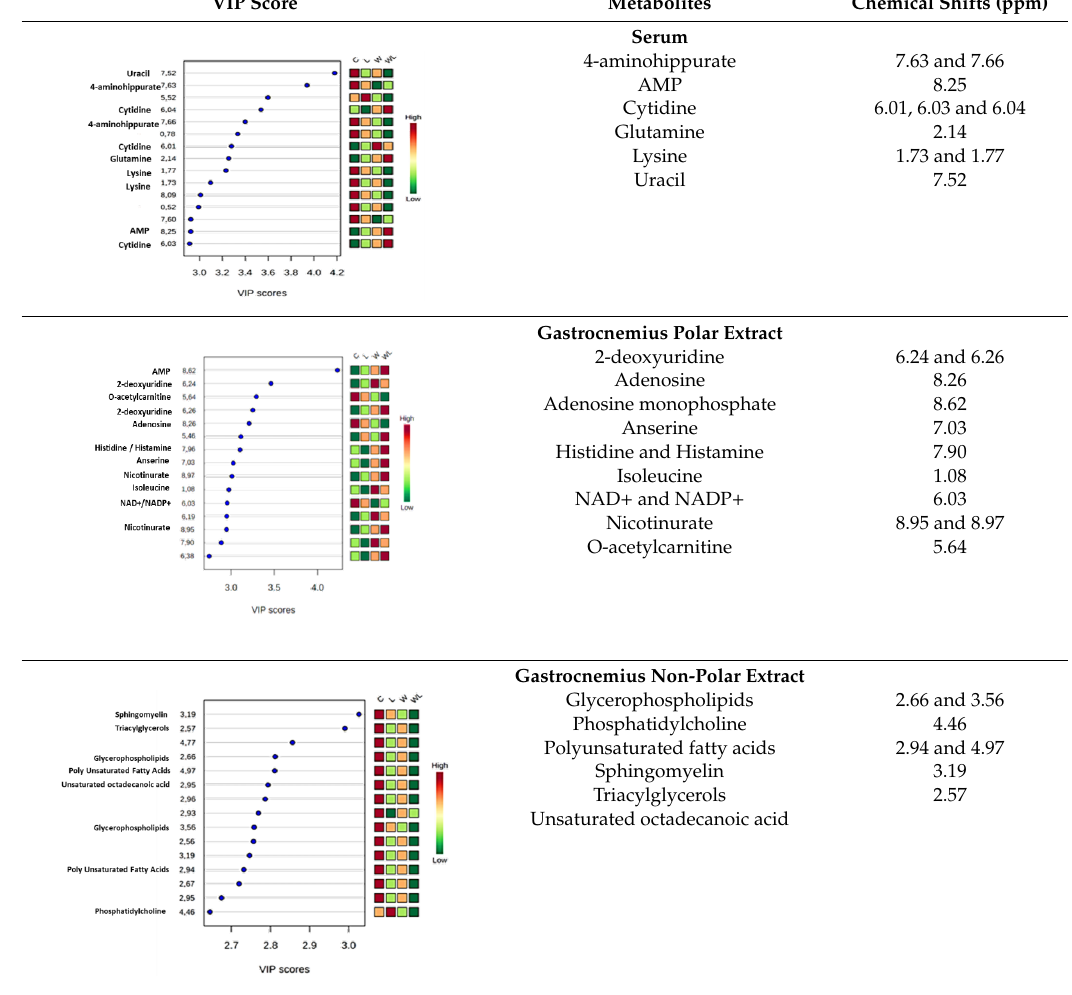
Figure 1. Results obtained from serum samples: ( a ) serum PLS-DA plot score; serum quantified metabolites, as normalized concentrations (µM); ( b ) cytidine; ( c ) uracil; ( d ) glutamine; ( e ) 4-aminohippurate, and (f) lysine. Legend: C, Control group ( n = 5); W, Tumor-bearing group ( n = 5); L, Group without tumors and with a maternal leucine-rich diet ( n = 6); WL, Tumor-bearing group with a maternal leucine-rich diet ( n = 6). For more details, see Material and Method section. a , p < 0.05 for statistical difference compared to C group; b , p < 0.05 for statistical difference compared to L group. Table 1. Serum and muscle metabolites obtained from VIP (variable importance in the projection) score analysis of all different experimental groups with or without tumor implant, subjected or not to a maternal nutritional supplementation. VIP Score